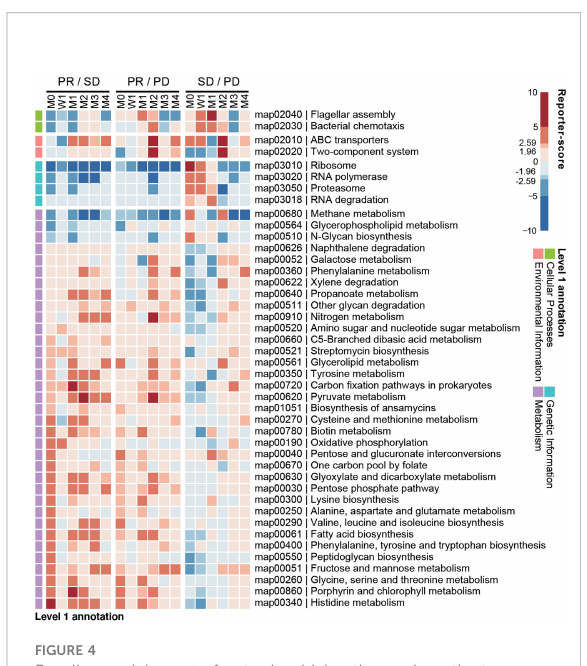
FIGURE 4 Baseline enrichment of gut microbial pathways in patients responding to anti-PD-1 therapy. KEGG-derived pathways from shotgun metagenomics data were computed by reporter-scores and compared pairwise between response groups. The enriched pathways were grouped based on the designated level 1 pathway categories. For each combination, a positive reporter- score (red) indicates the pathway was enriched in the response group (PR over SD and PD; SD over PD). A negative value (blue) indicates that the pathway was enriched in the non-response group. The signi fi cance of the differential enriched pathways was determined by reporter-score >1.96 or <-1.96 (equal to P < 0.05), and reporter score >2.59 or <-2.59 (equal to P <